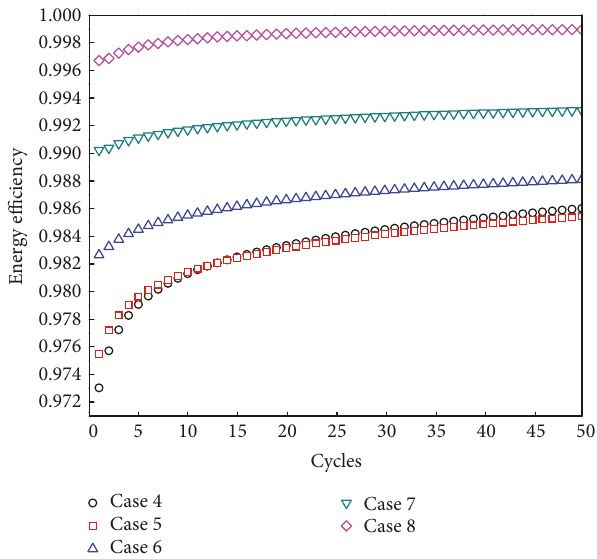
Figure 15: Comparison of the energy efficiencies in the continued cycles among the five depth